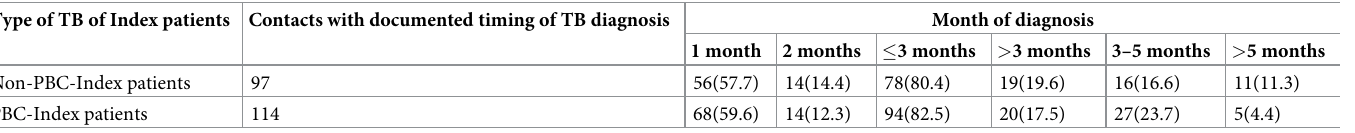
Table 3. Timing of TB diagnosis among contacts of non-PBC and PBC index